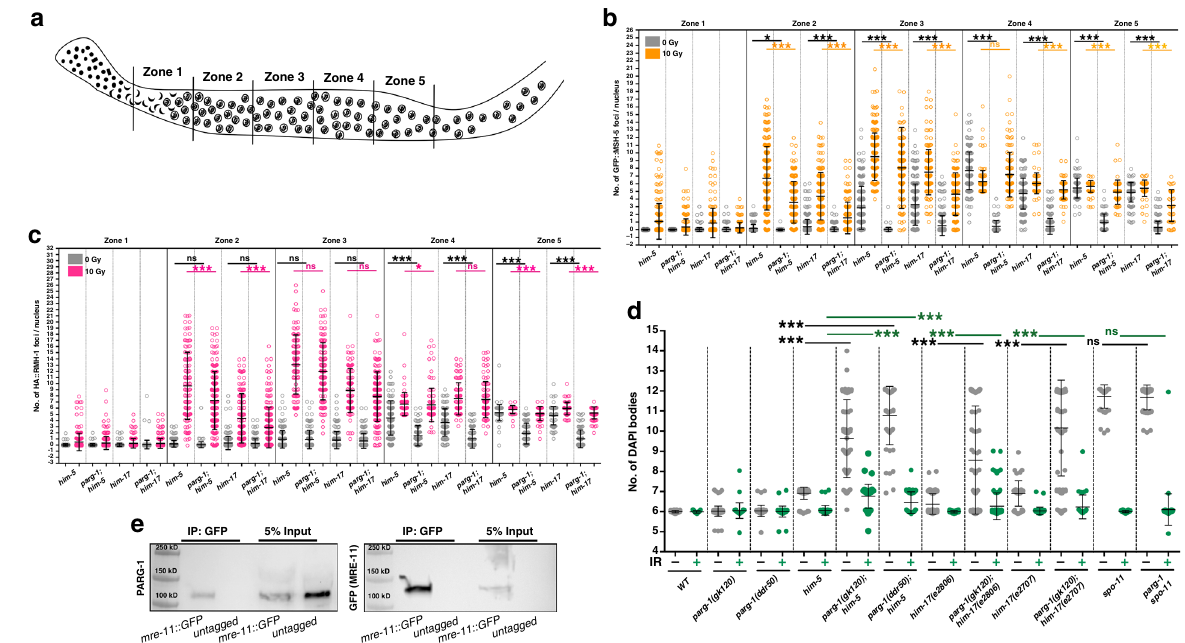
Fig. 4 PARG-1 promotes formation of meiotic DSBs and interacts with MRE-11. a Schematic representation of the gonad divided into fi ve equal regions spanning transition zone throughout late pachytene, employed for MSH-5 and RMH-1 foci quanti fi cation. b Quanti fi cation of GFP::MSH-5 foci in the indicated genotypes before and after IR. Center of error bars indicates mean. Error bars indicate standard deviation and asterisks indicate statistical signi fi cance assessed by unpaired t test (*** p < 0.0001, ns = not signi fi cant). Number of nuclei analysed is reported in Supplementary Table 1. c Quanti fi cation of HA::RMH-1 foci in the indicated genotypes before and after IR. Center of error bars indicates mean. Error bars indicate standard deviation and asterisks indicate statistical signi fi cance assessed by unpaired t test (*** p < 0.0001, ns = not signi fi cant). Number of nuclei analysed is reported in Supplementary Table 1. d Quanti fi cation of DAPI-bodies of different genotypes before and after IR exposure. Center of error bars indicates mean. Error bars indicate standard deviation and asterisks indicate statistical signi fi cance assessed by unpaired t test (*** p < 0.0001, ns = not signi fi cant). Number of nuclei analysed is reported in Supplementary Table 2. e Western blot analysis of endogenous PARG-1 on GFP pull downs performed in mre-11:: GFP and untagged wildtype strains (negative control). Analysis was performed in biological